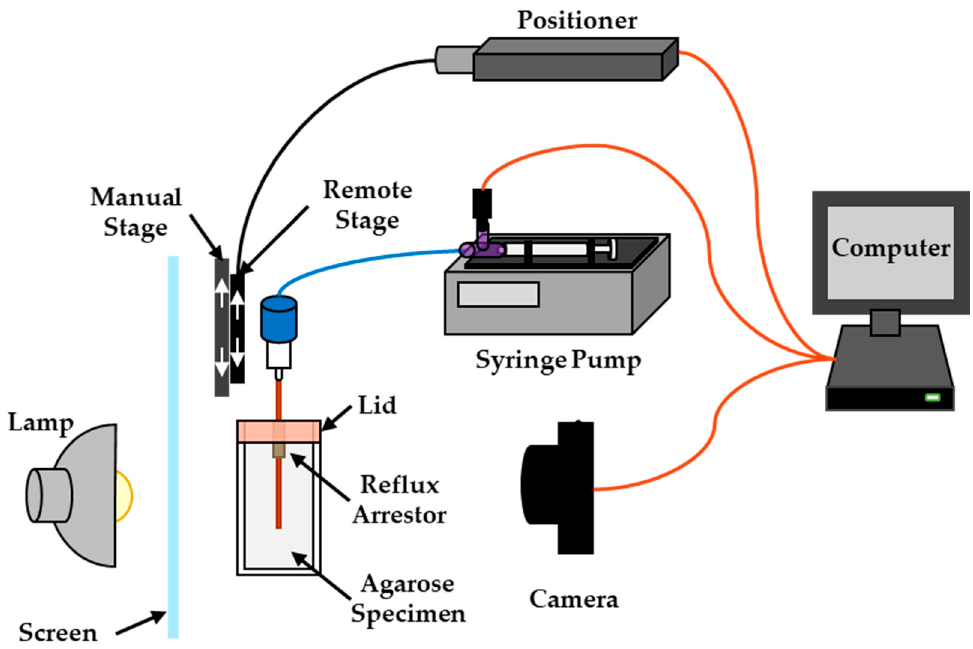
Figure 1. Schematic of shadowgraphy setup, where a linear positioner controls a stage used to move the catheter through a reflux arresting cannula into an agarose specimen. The manual stage allows for gross alignment of the catheter prior to insertion into the gel. A constant-flow syringe pump is used to deliver indigo carmine dye through the catheter and into the gel, while a camera is used to acquire images throughout the infusion.